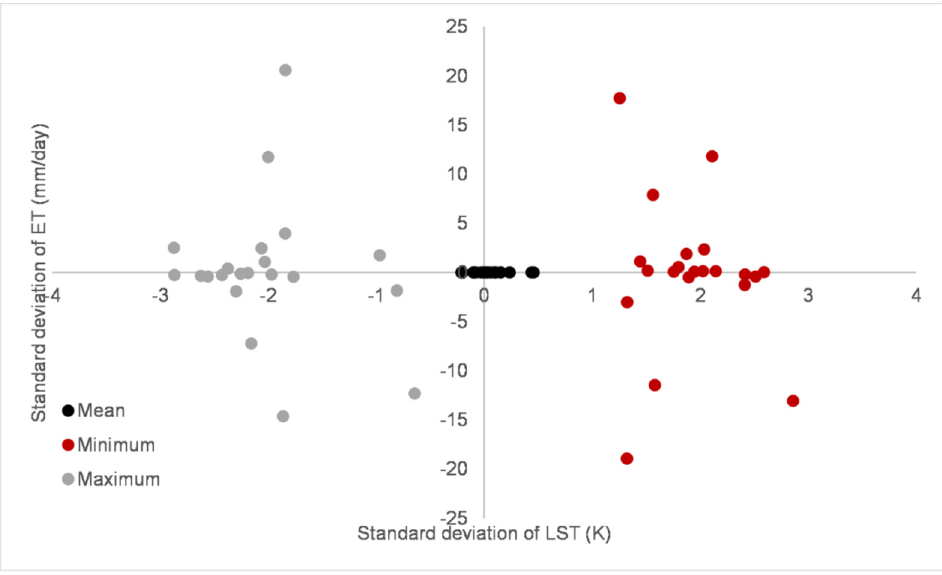
Figure 7. Changes of daily evapotranspiration (ET mm/day) against the changes of land surface temperature (Ts) input by gaussian variation of 2 K.